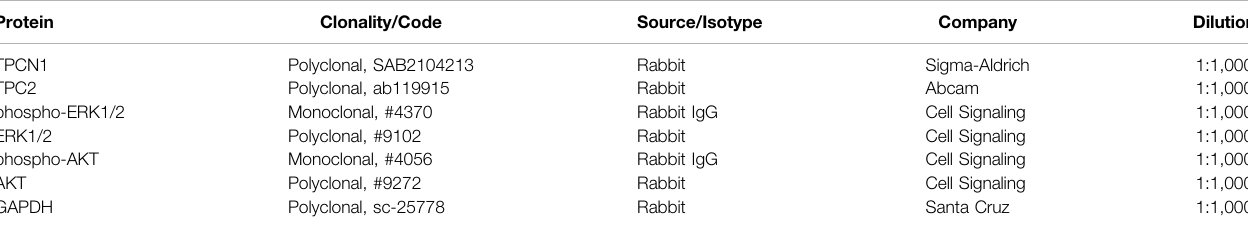
TABLE 2 | Primary antibodies.